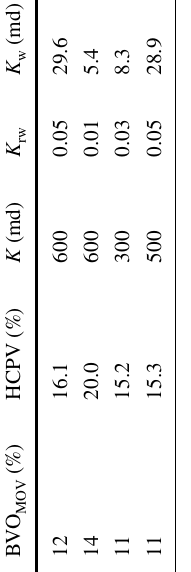
Figure 13c from the geological interrelationship of the major faults and structures in the field favours and led to the viability of the identified proven and prospective hydrocar- bon zones/ region of interest (ROI). ROI-1 is sandwiched between downthrown of F2 and upthrown of F3, while ROI 2 is sandwiched between downthrown of F3 and upthrown of F5 and F4 (see Fig.